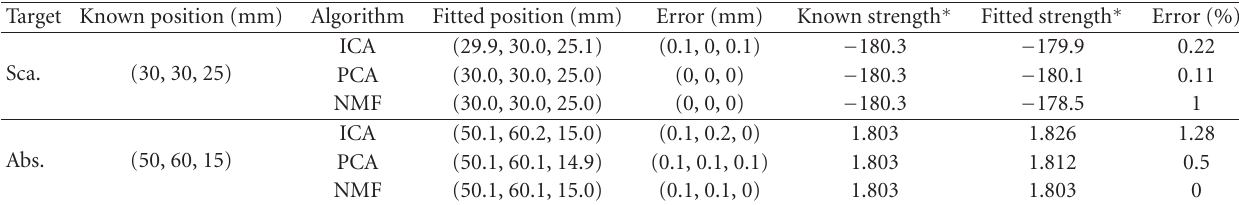
Table 1: Positions and optical strengths retrieved using simulated data and ICA, PCA, and NMF